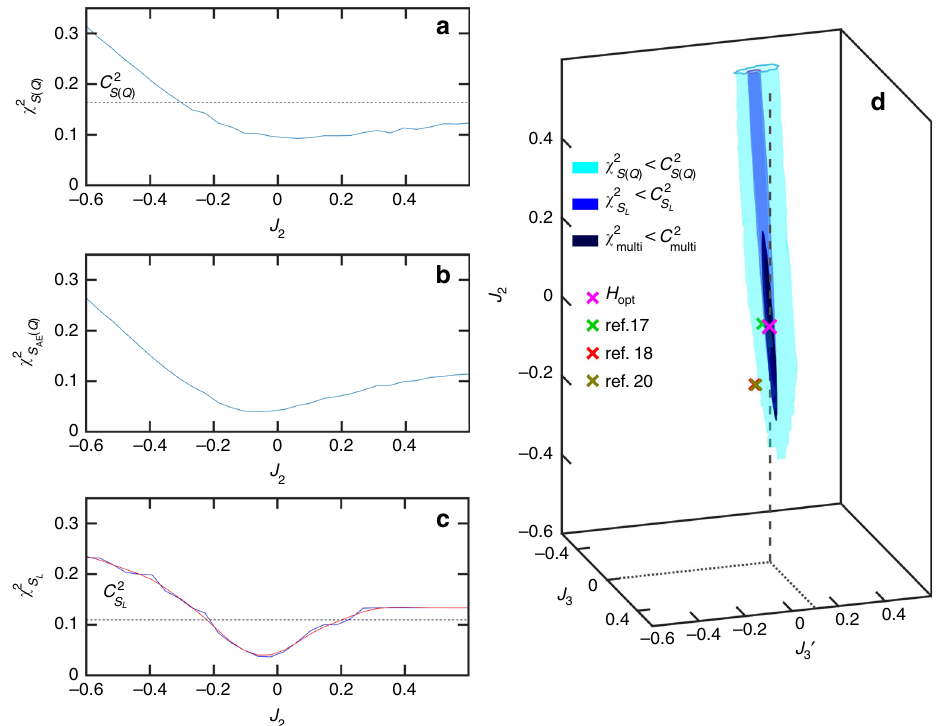
directly measures the distance between experimental and Fig. 4 Cost functions and their effects. Inferring the spin Hamiltonian for Dy 2 Ti 2 O 7 . a χ 2 S ð Q Þ simulated S ( Q ) data. It is relatively fl at and noisy around its minimum, thus yielding a large uncertainty in the J 2 coupling (any value below the dashed line, C 2 χ 2 measures the distance between S ( Q ) data after being fi ltered through the autoencoder. c χ 2 S measures the S Q ð Þ , is a reasonable candidate). b S L AE ð Q Þ H ð Þ (red curve) accurately distance between the 30-dimensional latent space representations of the S ( Q ) data. The Gaussian process model ^ χ 2 S L approximates χ 2 S , even in the full space of J 2 , J 3 , and J 3 0 . d Once a good model ^ χ 2 S ð H Þ has been constructed, we can rapidly identify the optimal Hamiltonian L L model (magenta cross). The autoencoder-based error measure χ 2 S yields much smaller model uncertainty (blue region) than the naïve one χ 2 S (cyan ð Q Þ L region). Model uncertainty is further reduced using a multi-objective error measure χ 2 that incorporates heat capacity data (dark-blue region). Three multi most popular Hamiltonian sets currently used from refs. 17,18,20 have also been marked as green, red and gray crosses